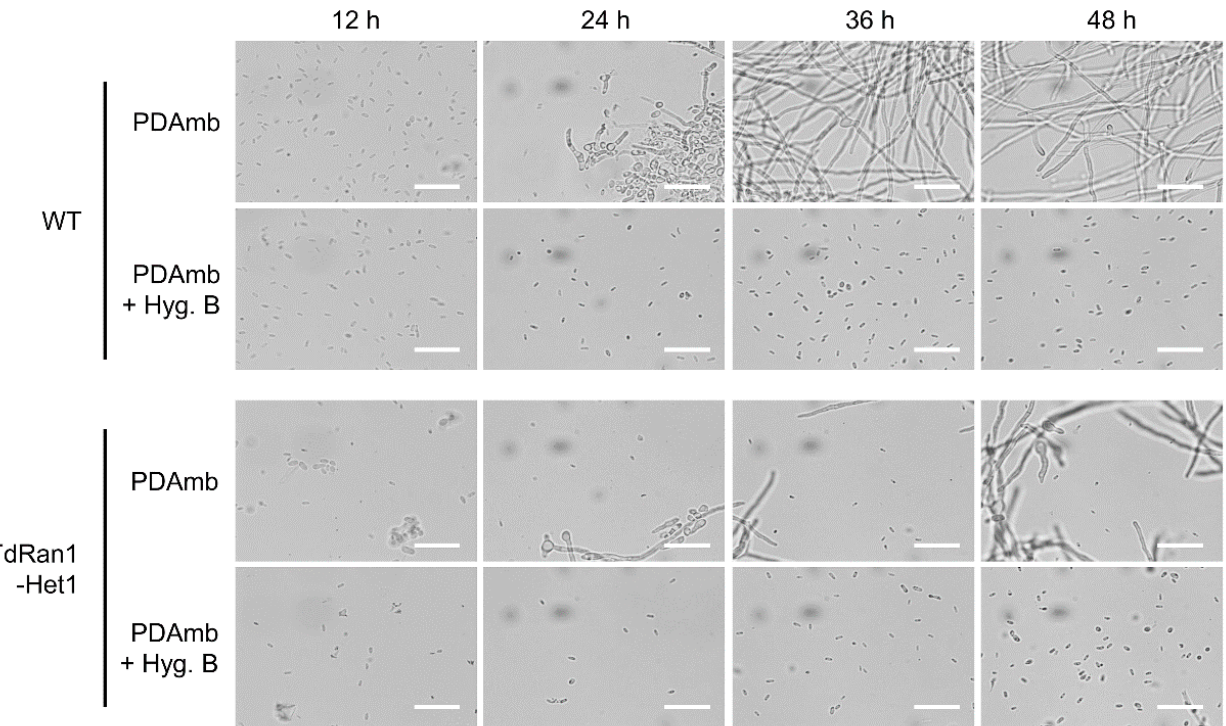
Figure 4. Microscopic observation of germinating conidia. Conidia are observed at every 12 h until 48 h, and the incubation time is shown above the panel. The strains compared are wild-type EP155/2 (WT) and heterokaryotic CpRan1 -null mutant (TdRan1-Het1). The culture media indicated on the left of the panel are potato dextrose broth (PDB) and hygromycin B-supplemented PDB (PDB + Hyg. B). Scale bar = 50 μ m.